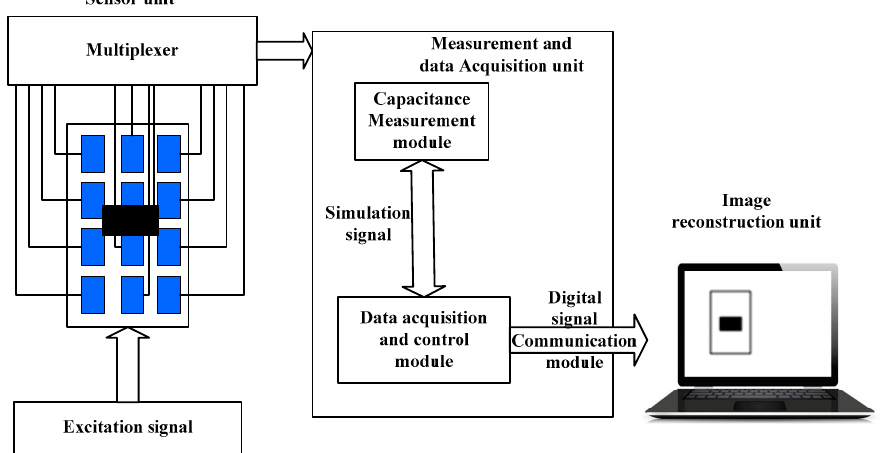
Figure 1. Electrical Capacitance Tomography (ECT) system structure diagram.